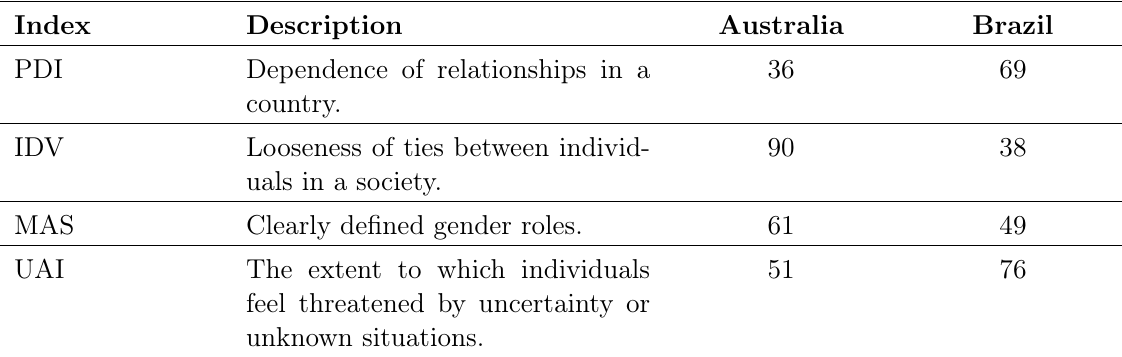
Table 4. Indexes of Dimensions of National